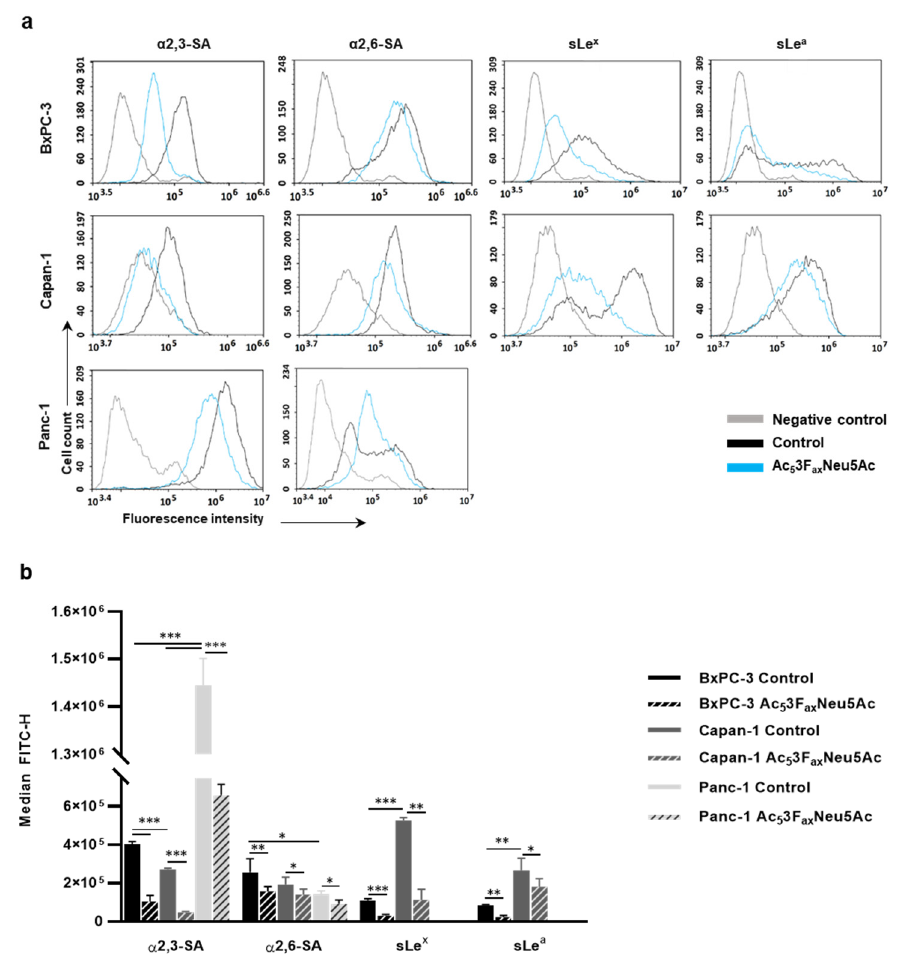
Figure 1. Analysis of Ac 5 3F ax Neu5Ac treatment on cell sialylation in BxPC-3, Capan-1, and Panc-1 cells. ( a ) Representative histograms of the sialylated glycans expression on the cell surface of treated and control BxPC-3 (top panel), Capan-1 (medium panel), and Panc-1 (bottom panel) cells α 2,3-SA (detected by MAA-II lectin) α 2,6-SA (detected by SNA lectin), sLe x (mAb CSLEX), and sLe a (mAb 121SLE) (from left to right). Description of what is contained in the first panel; ( b ) Median fluorescence for each glycan structure of treated and control BxPC-3, Capan-1, and Panc-1 cells are represented. Plots show the mean ± SD of at least three independent experiments. * p < 0.05, ** p < 0.01 and *** p < 0.001. 3.2. Ac 5 3F ax Neu5Ac Impaired E-Selectin Binding in BxPC-3 and Capan-1